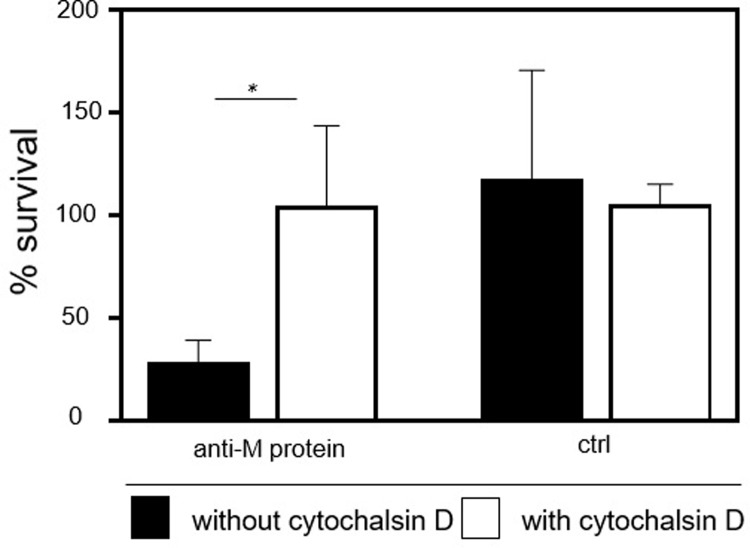
Antibodies to the M protein inhibit growth of GAS in blood.Growth and viability of GAS in murine blood. GAS was pre-incubated for 30 min. with IgG to the M protein or non-immune IgG (ctrl) prior to suspension in murine blood that contained, or not, cytochalasin D. After an additional 30 min., viable bacteria were enumerated by dilution plating. The results shown are the means ± sem from 4 independent experiments. Statistical significance was determined with the Student's t-test.